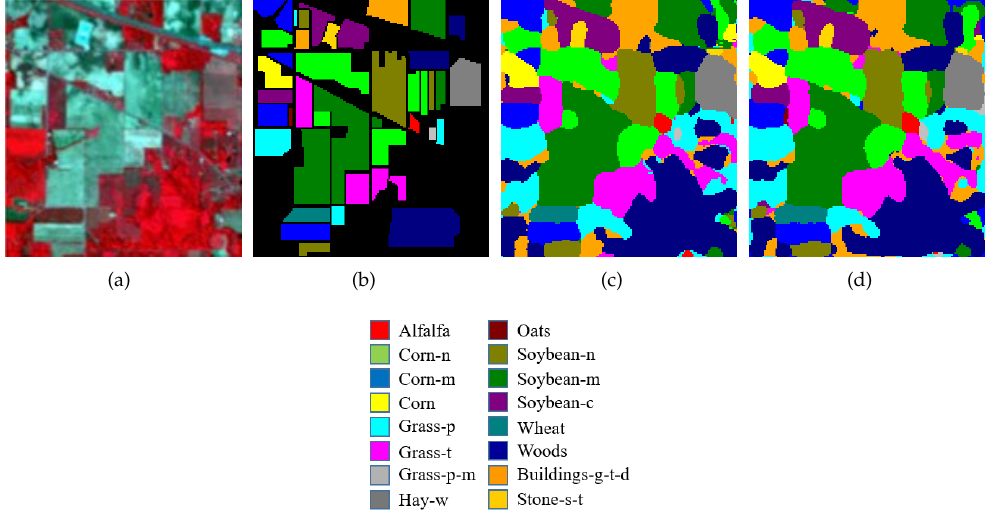
Figure 6. Visual classification results on the IP dataset. ( a ) A three-band color composite image, ( b ) the ground-truth image. Classification results of input image patch size ( c ) 7 × 7, ( d ) 11 ×